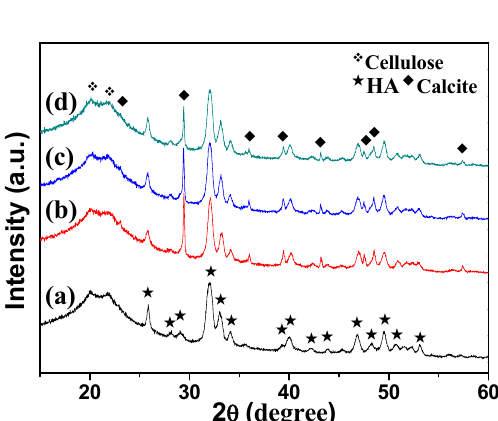
Figure 6. XRD patterns of the cellulose/HA nanocomposites prepared by microwave-assisted hydrothermal method at 180 °C for 10 min using different phosphorus sources: ( a ) NaH 2 PO 4 ·2H 2 O; ( b ) ATP; ( c ) CP; ( d ) FBP.